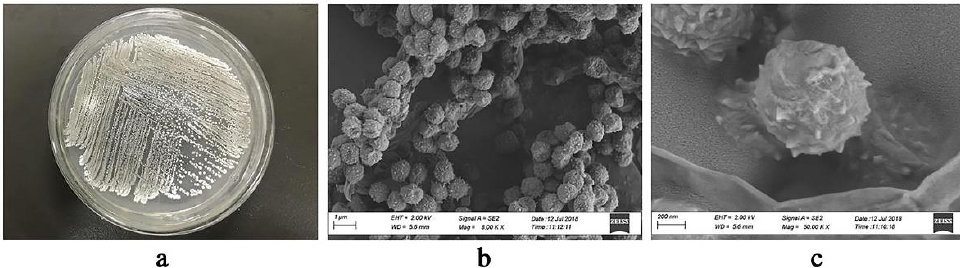
Figure 3. The morphology of strain S. griseorubens f8. ( a ) shows the morphology of strain S. griseorubens f8 on M1 medium. ( b ) shows the morphology of the strain S. griseorubens f8 spores under SEM. ( c ) shows the morphology of a single spore under SEM.